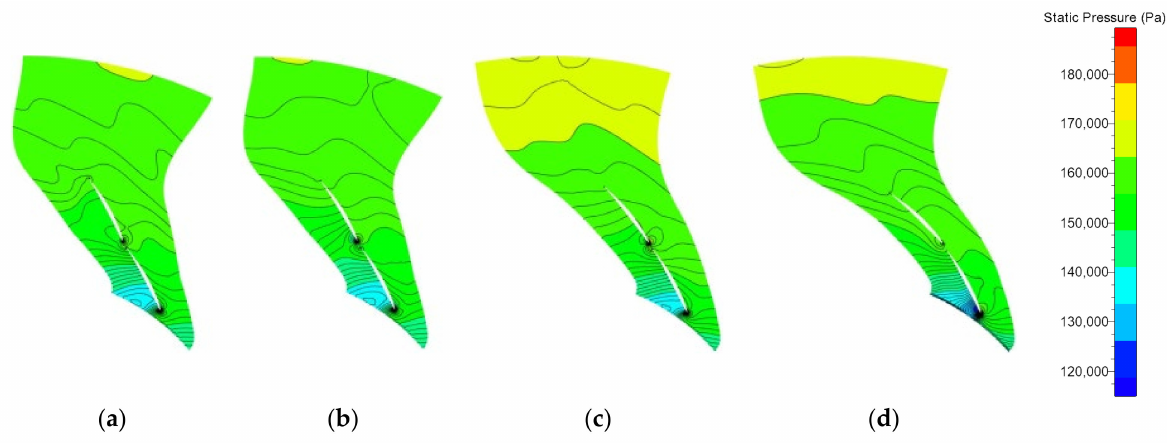
Figure 15. Static pressure distribution at 10% span in different cases. ( a ) 0 ◦ model; ( b ) 3 ◦ model; ( c ) 10 ◦ model; and ( d ) 18 ◦